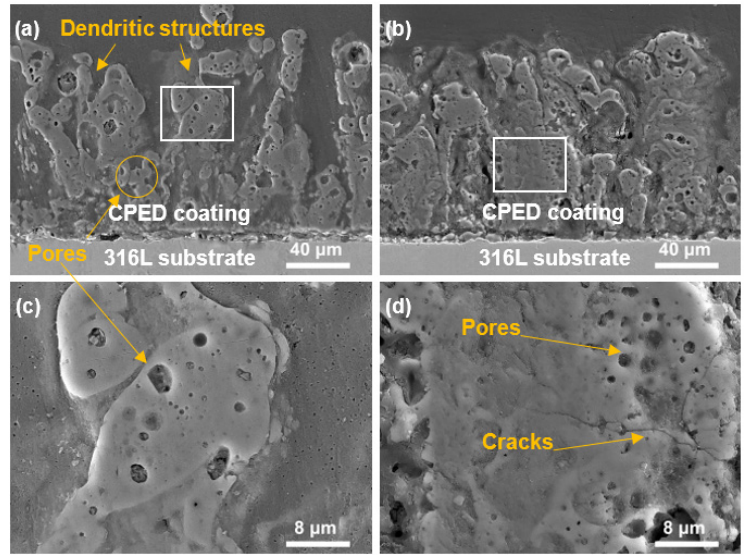
Figure 7. Cross-sectional SEM morphologies of CPED coatings: ( a ) cross section of sample S0; ( b ) cross section of sample S15; ( c ) high-magnification image of ( a ); ( d ) high-magnification image of ( b ).